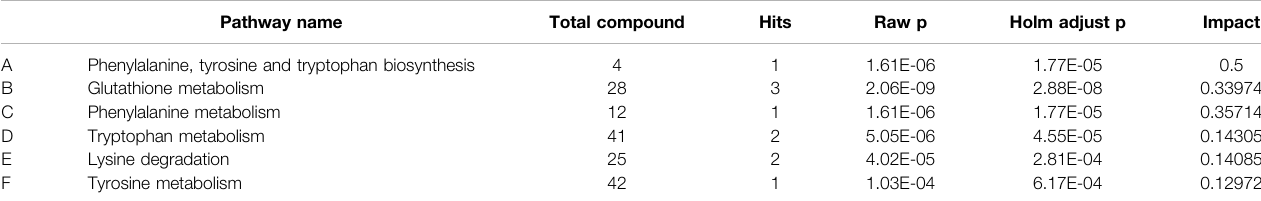
TABLE 4 | Summary of pathways with Metaboanalyst (CUMS vs.